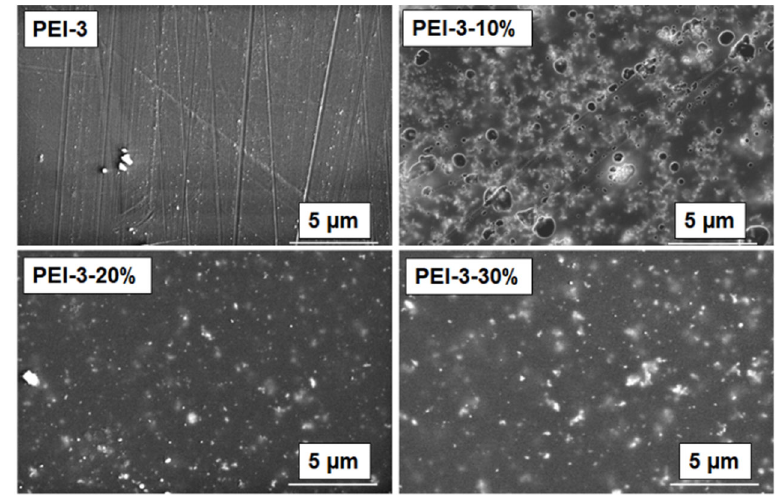
Figure 2. SEM micrographs of PEI ‐ 3 film and PEI ‐ 3 (10–30%) composite films.